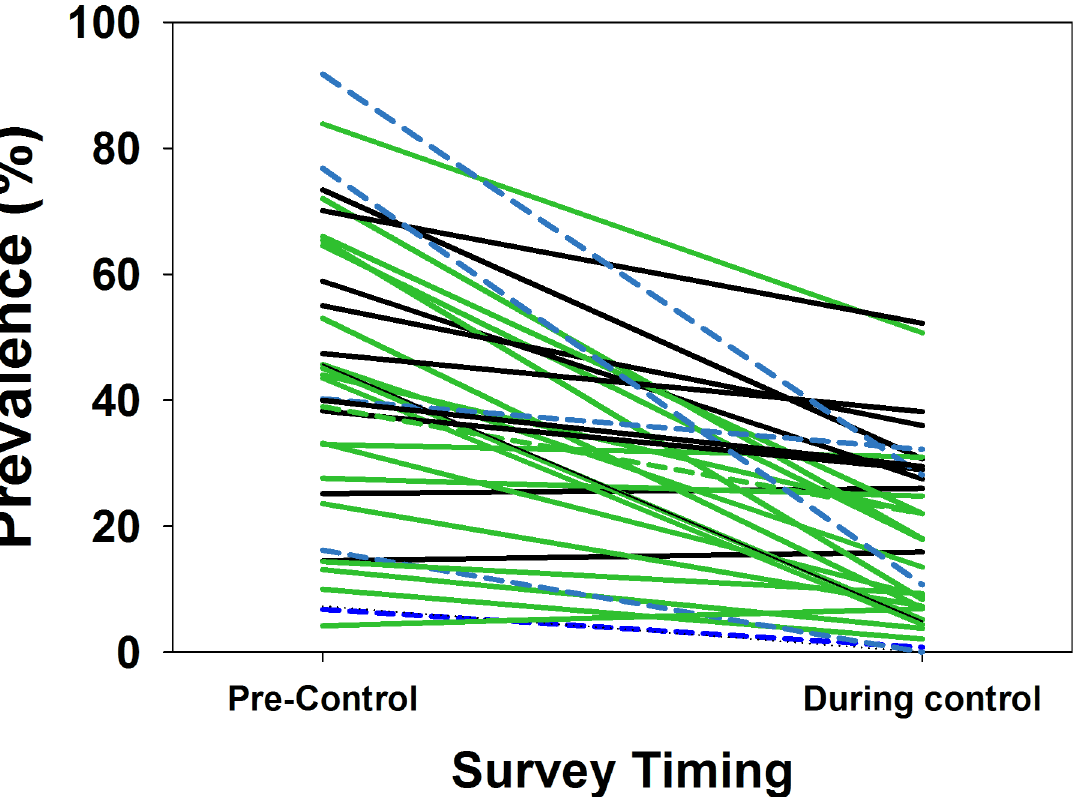
Fig 3. Change in local human prevalence of Schistosoma infection during mollusciciding control projects. Individual lines represent the shift from pre-control prevalence (left side) to prevalence after implementation of chemical mollusciciding (right side) by schistosomiasis control programs. Black lines indicate programs that used niclosamide mollusciciding alone, green lines indicate programs that combined mollusciciding with anti-schistosomal drug treatments as part of control, and the dashed blue lines indicate studies where non-niclosamide molluscicides were utilized.